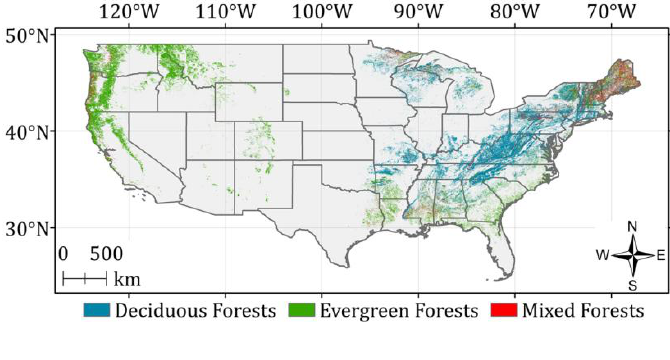
Figure 1. Forested lands (1 km spatial resolution) over the continental USA (CONUS) based on the National Land Cover Database (NLCD) 2006 land cover. Three forest types—deciduous, evergreen, and mixed forests—with percent tree cover ≥50% were considered in this